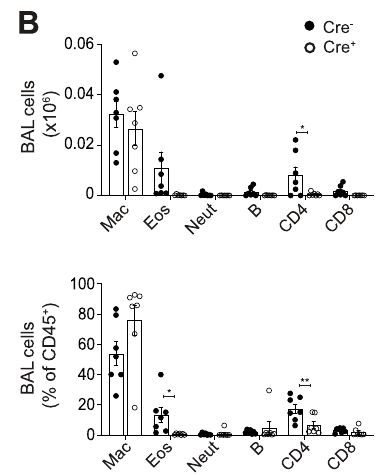
ionomycin, and cytokine production assessed via fl ow cytometry. Data are from 2 experiments ( n =14 biologically independent animals). Data were fi t to a linear mixedeffectmodel,withexperimentaldayasarandomeffectvariable,andgroups compared with a two-sided LS means Student ’ s t test. * p <0.05, ** p <0.01, *** p <0.001.Dataarepresentedasmeanvalues±SEM.Sourcedataareprovidedas a Source Data fi